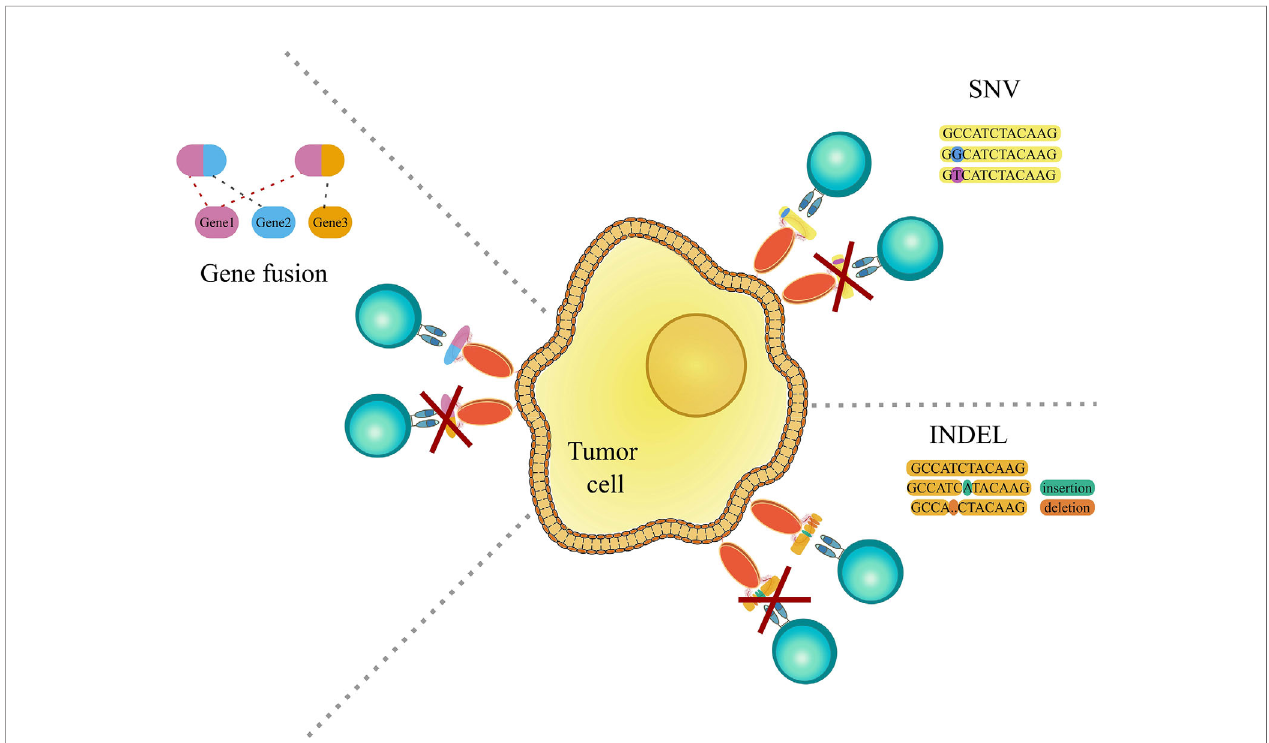
FIGURE 1 | Graphic representation showing genomic aberrations, which can lead to the occurrence of cancer-speci fi c peptides (neoepitopes). The left panel shows gene fusions, which is the rearrangement of two genes leading to the encoding and translation of a potentially novel immunogenic peptide. The right upper panel shows single nucleotide variations (SNV) and the right lower panel shows insertions and deletions (indels), that may cause the creation of immunogenic cancer- speci fi c peptides. For further detail see the main